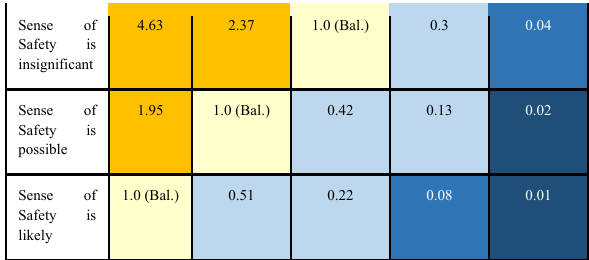
Figure 8 - Topophilia Exposure Spatial Binning Index This color scheme for Figure 6 is the same for figures 3, 4, 6, and 7. The Red to Dark Red signify a 99% Risk Hotspot or Unsafe Tessellated Space, but comfort and origin remain variable and difficult to measure; The Light Orange to Red signify a 95% Risk Hotspot or Unsafe Tessellated Space, but comfort and origin remain variable and difficult to measure; The Light Orange signify a 90% Risk Hotspot or Unsafe Tessellated Space, but comfort and origin remain variable and difficult to measure; The Light Yellow signify Random value or insignificant tessellated space; The Light Blue signify a 90% Safe Tessellated Space, but not necessarily a comfortable location (central space that covers 100 hectares of land surface); Blue signify a 95% Safe Tessellated Space, but not necessarily a comfortable location; and The Dark Blue signify a 99% Safe Tessellated Space, but not necessarily a comfortable for some relocated or resettled families.